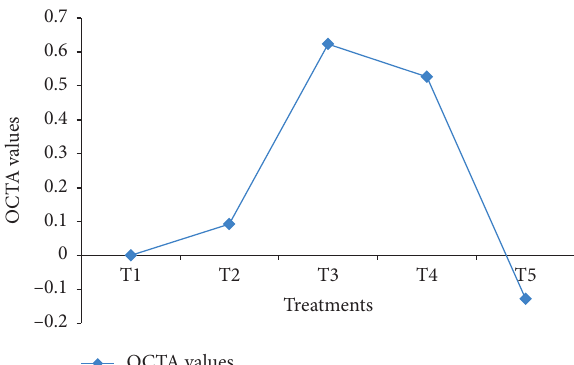
Figure 5: OCTA trend for height of plants (HOP).